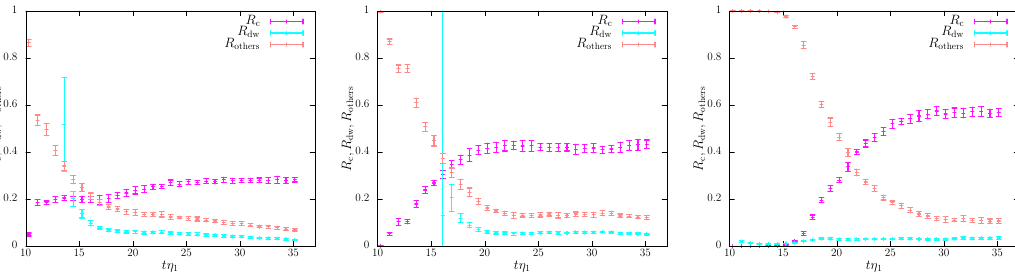
Figure 14 . The time-evolution of R c; dw ; others for various (cid:17) 2 =(cid:17) 1 . We take (cid:17) 2 =(cid:17) 1 = 0 : 75 ; 0 : 50 ; 0 : 25 from left to right. The other parameters are (cid:12)xed to the values in eq. (4.1). The rightmost panel is the same with (cid:12)gure